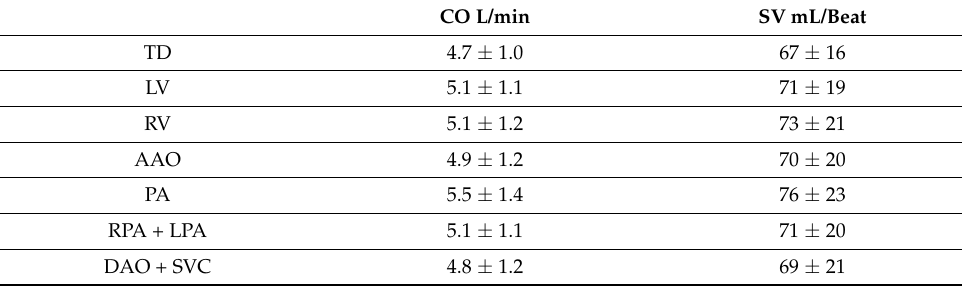
Table 3. Mean and standard deviation values for CO and